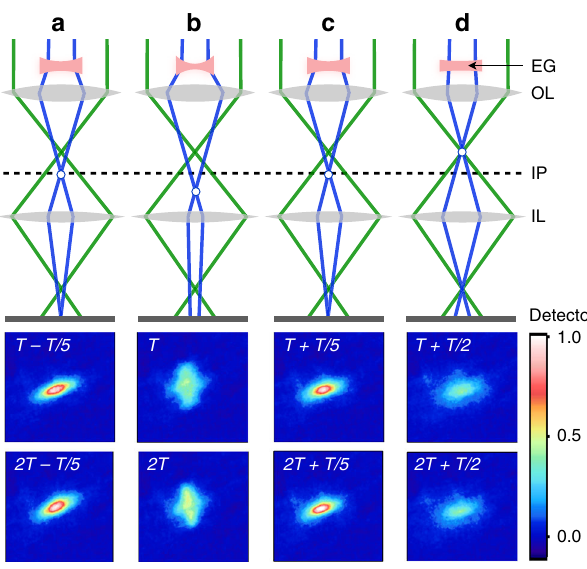
Fig. 6 Double-peak structure in ROI difference intensity traces and astigmatism of the electron-gas lens. Schematics of the electron gas (EG, red) acting as a biconcave lens while it reaches its largest lensing strength ( b ). The intermediate lens (IL) current (0.95 A) is set such that the image plane (IP) denoted by the dashed line is projected onto the detector. Depending on the strength of the EG lens, the crossover point (open circle) lies either on ( a , c ), below ( b ), or above ( d ) the IP. Under these conditions the ROI difference intensity shows a double-peak structure (see e.g. Fig. 5d, different data set), with local maxima appearing at approximately nT ± T /5 ( n = 0, 1, 2, … ), T being the cyclotron period as de fi ned in the text. The focal point is astigmatic due to the elliptical shape of the EG lens, as is seen by the rotation of the elongated focal point as it moves through the IP. The objective lens (OL) current was set to 0.7 A, with T = 165